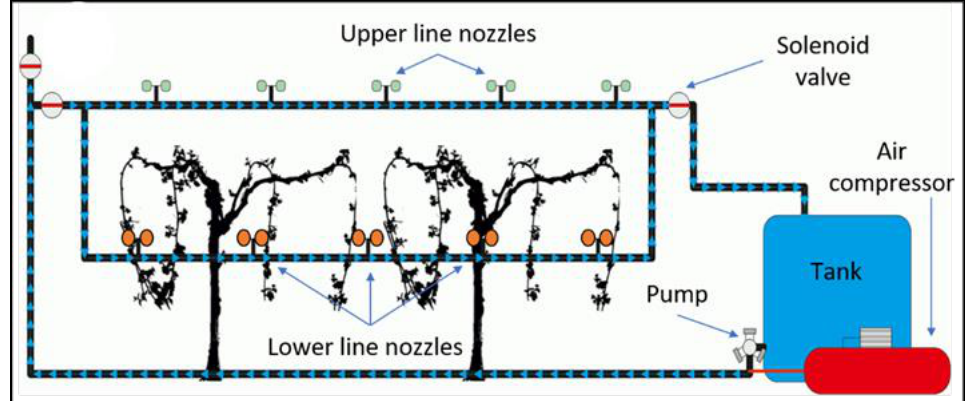
Figure 3. Scheme of the fixed spray system.